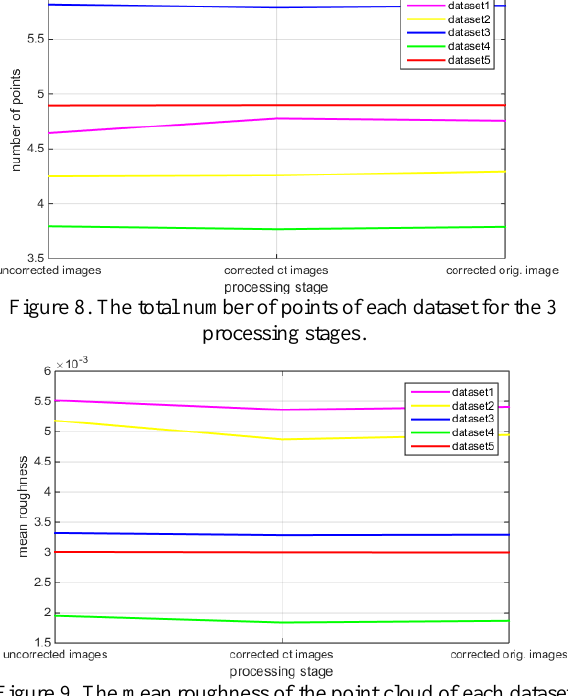
Figure 9. The mean roughness of the point cloud of each dataset for the 3 processing